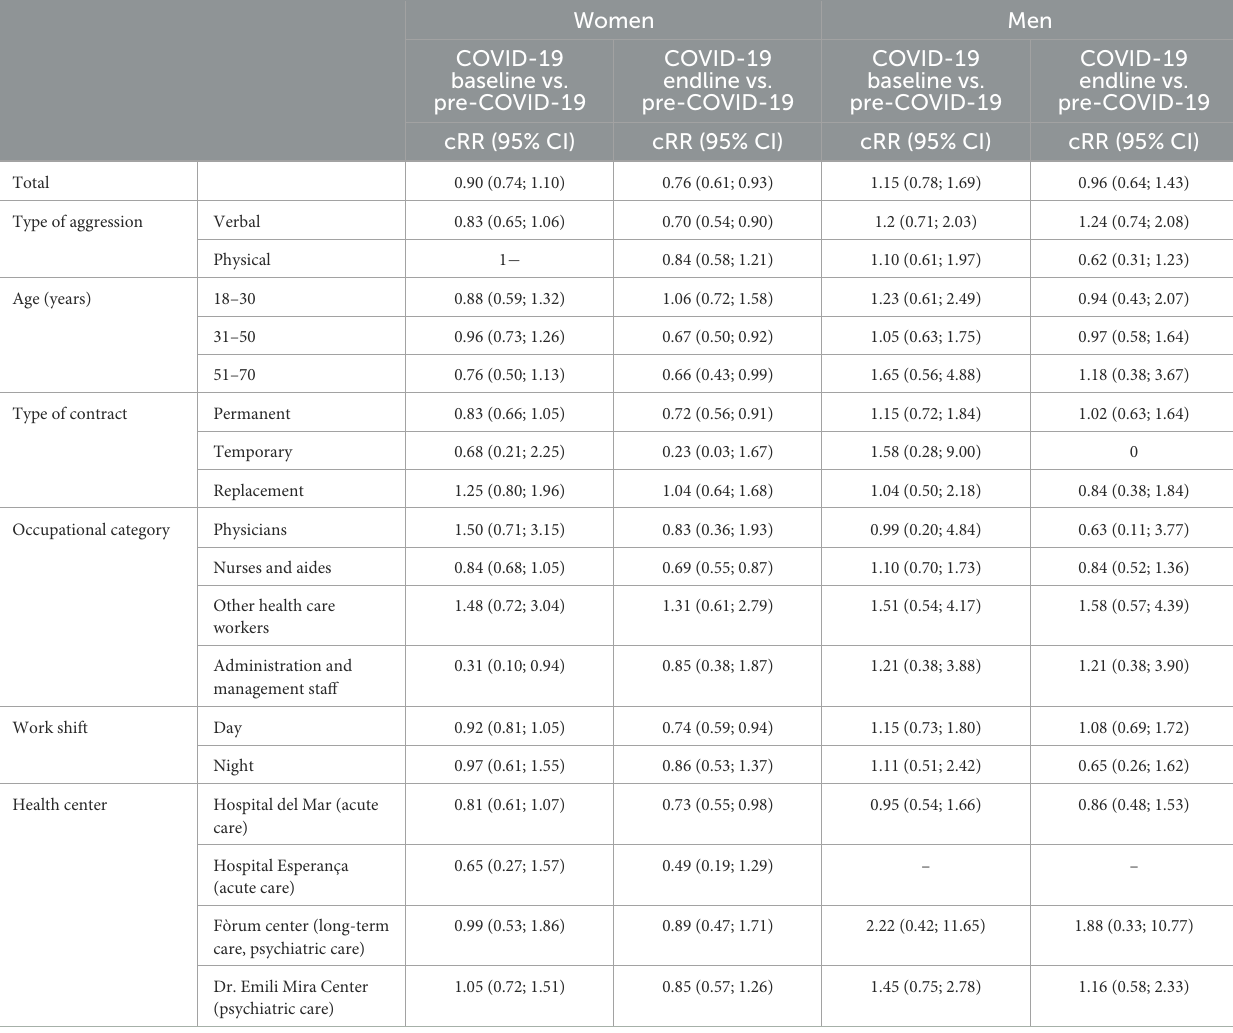
TABLE 4 Crude relative risk (cRR) and 95% confidence intervals (95% CI) of aggressions between time periods ∗ according to type, sociodemographic and occupational variables, by sex.